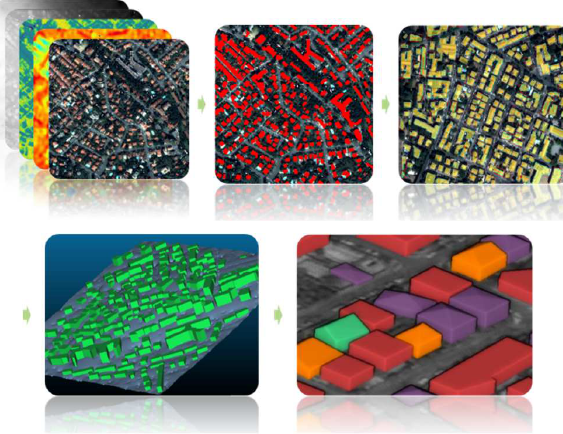
Fig. 8. 3D pipeline: Inputs (PHR multiview, C3, NDVI), intermediate extracted building, LOD0, LOD1 and finally LOD2 (first results).